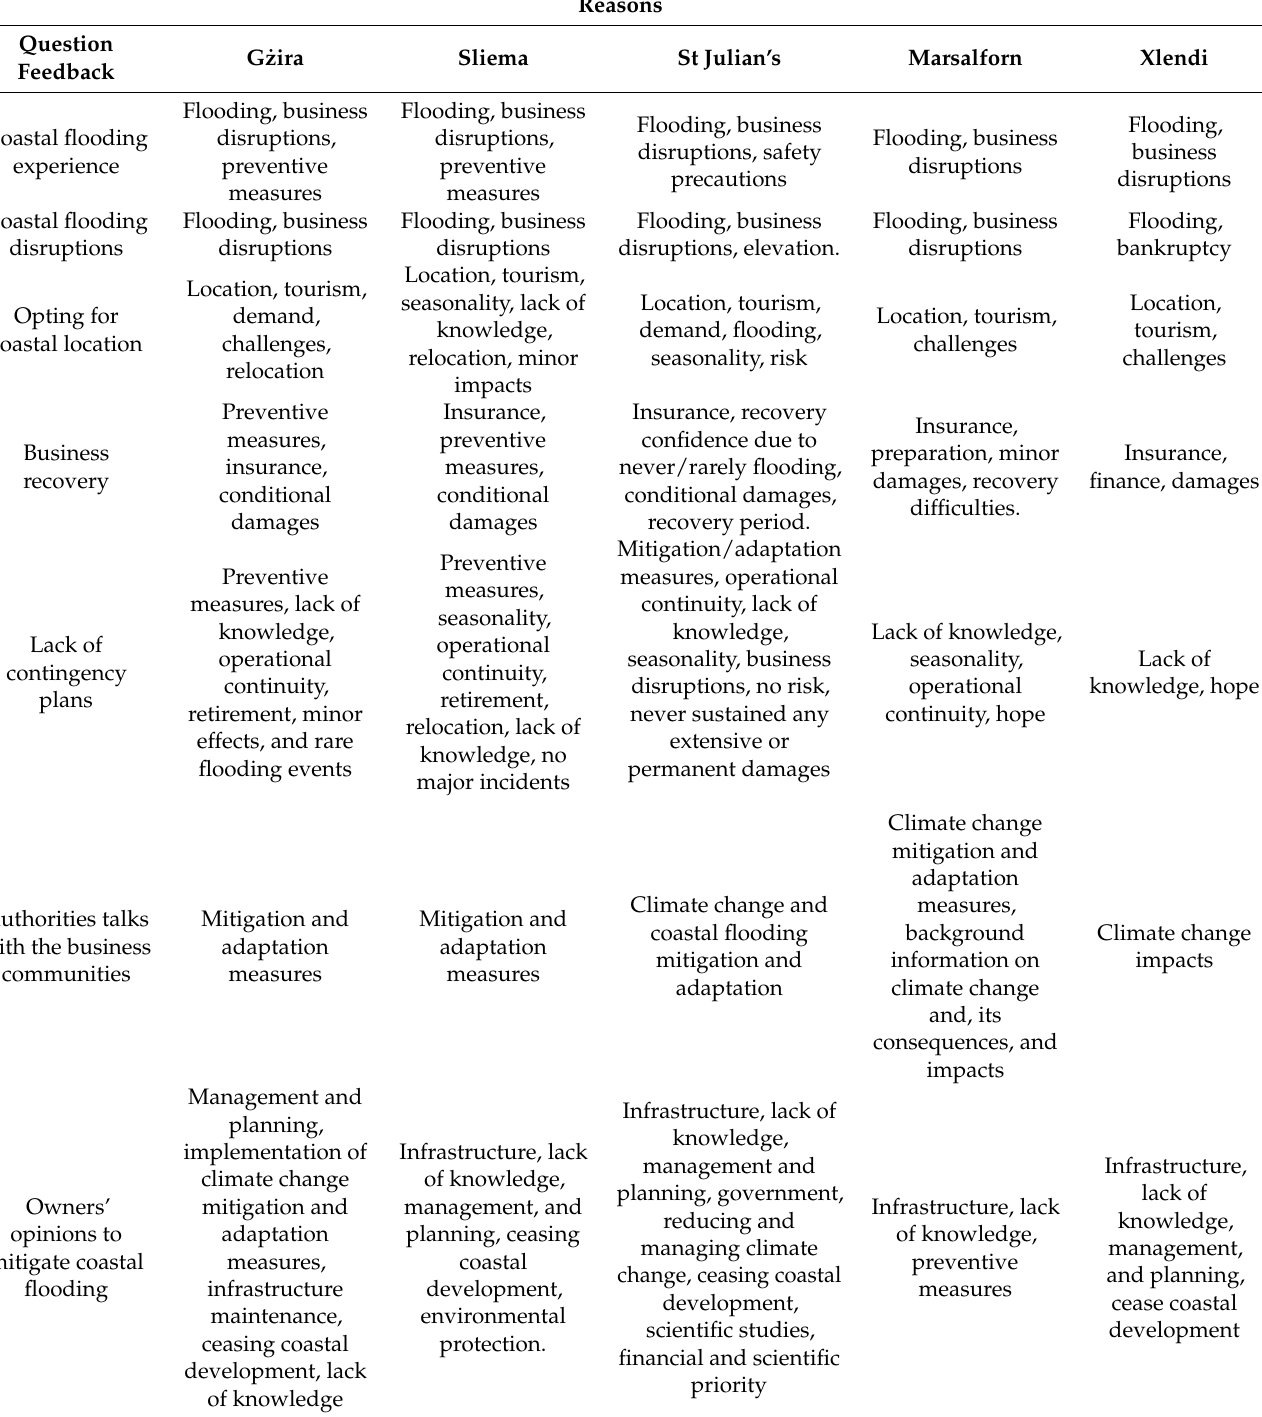
Table 3. Reasons provided by the business owners in the qualitative